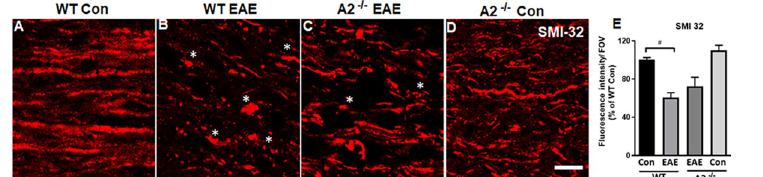
Fig 4. Deletion of A2 reduced EAE-induced axonal degeneration. A-D) Confocal images of optic nerve sections from WT EAE mice demonstrate disorganized and damaged axons in the EAE optic nerves. Asterisks ( � ) indicate areas of axonal damage. E) Quantification of SMI 32 fluorescence intensity using ImageJ. Number of animals used: 8 (WT Control);12 (WT EAE); 9 (A2 -/- EAE); 7 (A2 -/- Control). Representative images are presented. Data are presented as mean ± SEM. #p < 0.01 WT EAE vs WT Con and A2 -/- EAE vs WT EAE is non-significant. Scale bar 20 μ m.